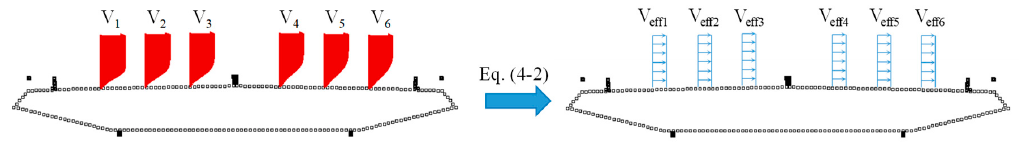
Figure 12. Boundary layer flow profile to equivalent uniform profile.